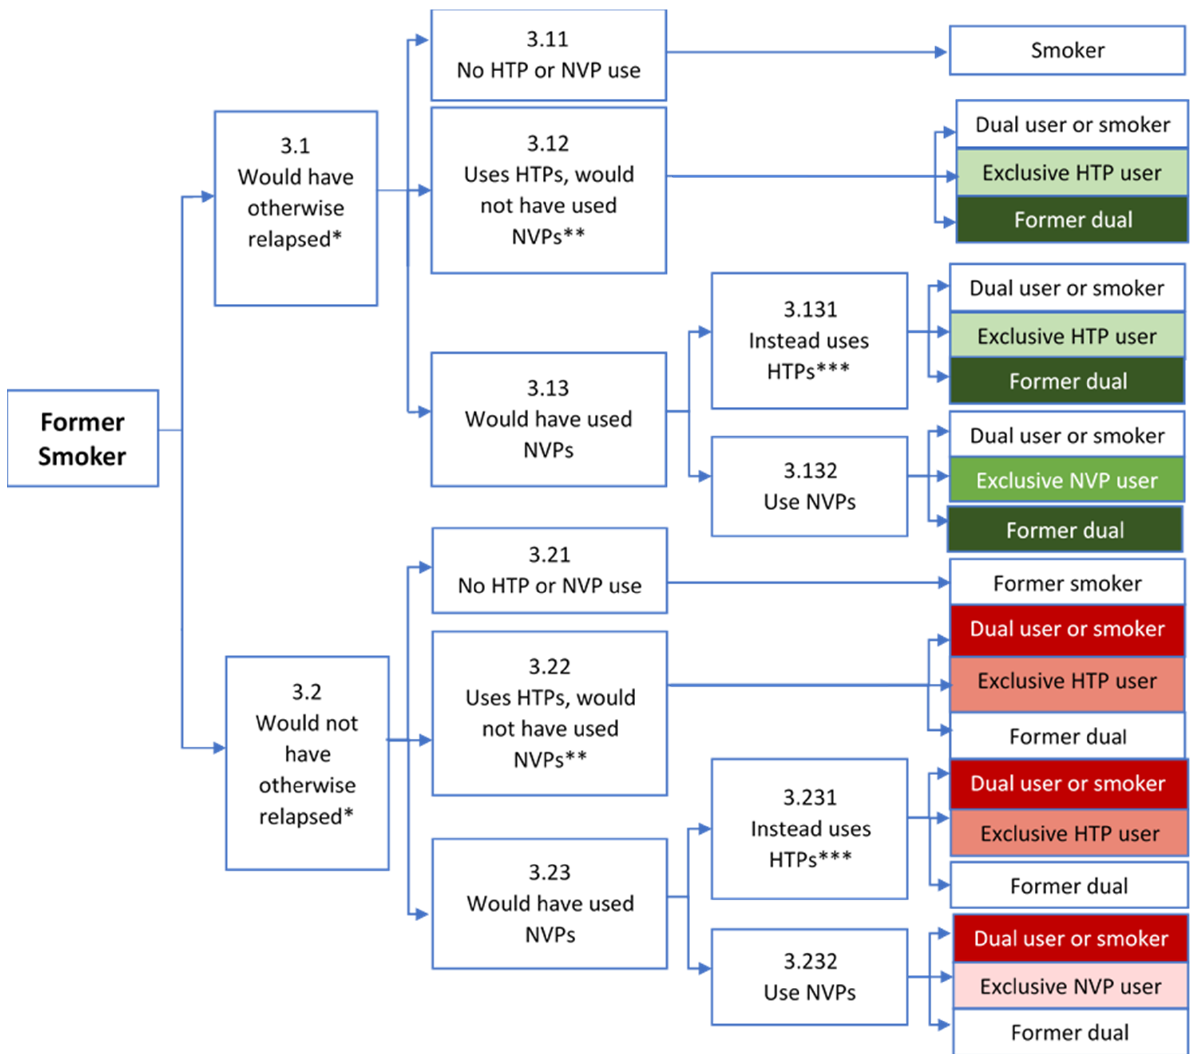
Figure 3. Public Health Impact of NVP and HTP Use Among Former Smokers. Notes: HTP = Heated Tobacco Product, NVP = Nicotine Vaping Product. * Based on the counterfactual of whether smoking relapse would have occurred in the absence of both HTPs and NVPs. ** HTPs are a more desirable alternative to NVPs, e.g., tried NVPs and not found desirable or satisfactory. *** Would have otherwise preferred NVPs, but diverted from use due to industry behavior or govern- ment policy. Green indicates public health benefit; Red indicates public health loss. Darker shades indicate a greater